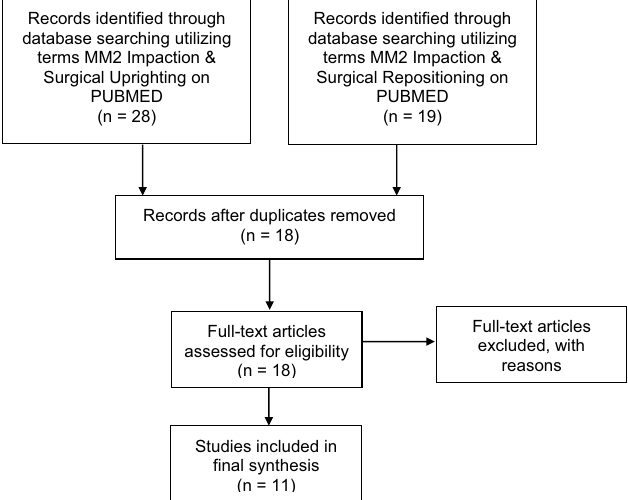
Fig. 1. This fl ow diagram describes the number of records identi fi ed, excluded and included in assessing treatment outcomes for this narrative